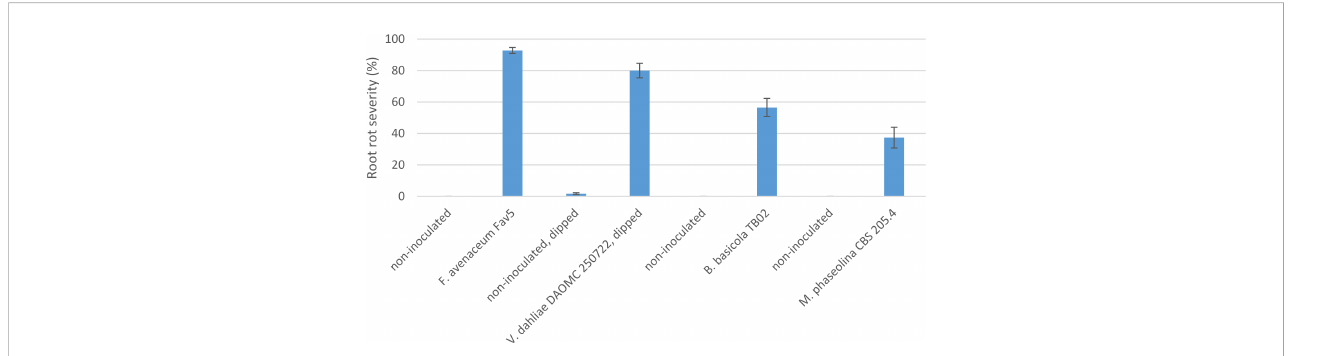
FIGURE 5 Root rot severity (%) caused by four pathogens on 3-week-old plants of CDC Leader kabuli chickpea under controlled conditions. Inoculum was incorporated into soil at planting or applied as a seedling dip, and applied by soil drenching 10 days after seeding or